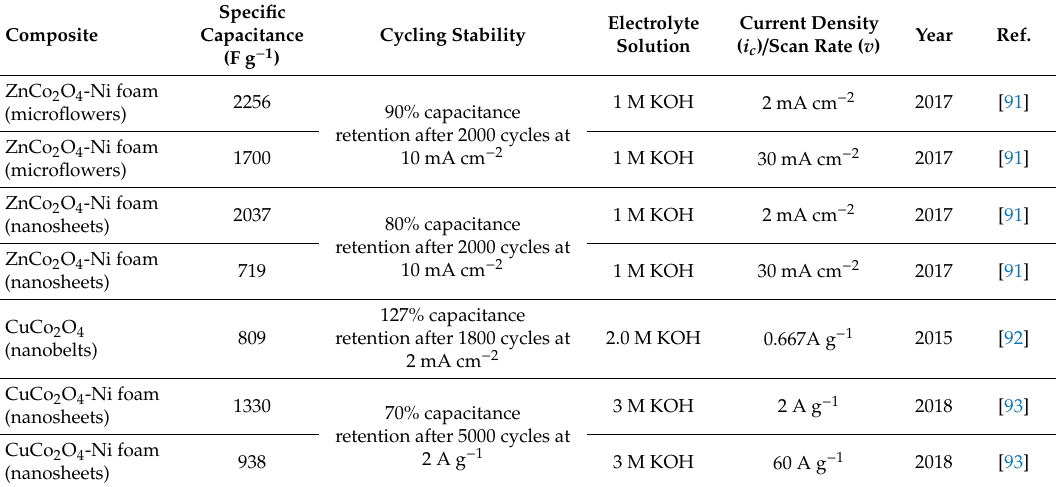
Table 5. Composite with specific architectures with various